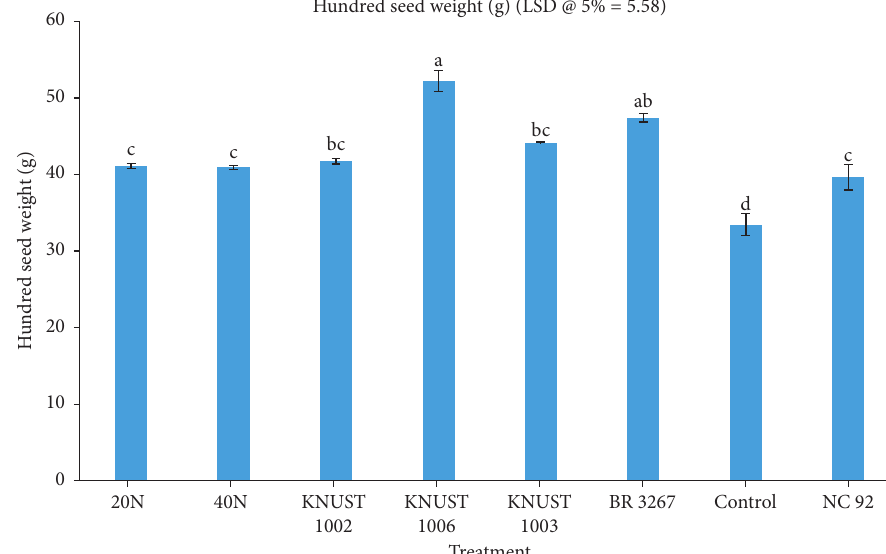
Figure 3: Effects of rhizobial inoculation and N fertilizer application on hundred seed weight of groundnut. Bars with different letters denote significance at P < 0 . 05. Error bars denote the standard error of means. Means comparison was conducted using least significant difference.